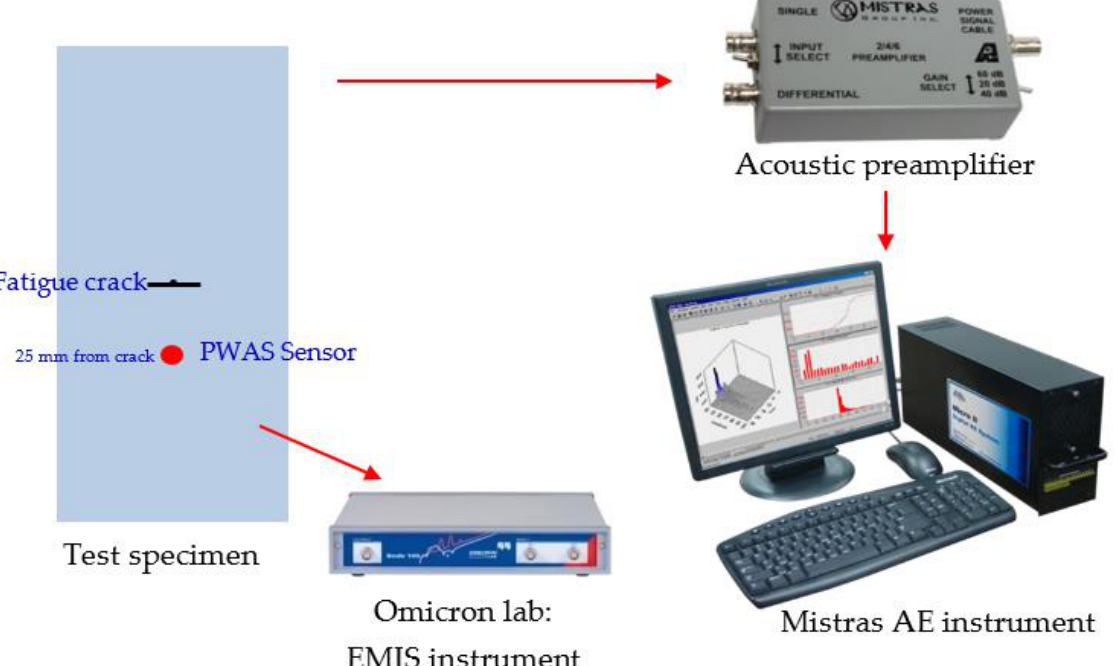
Figure 9. Experimental setup to capture AE signals during a fatigue-crack